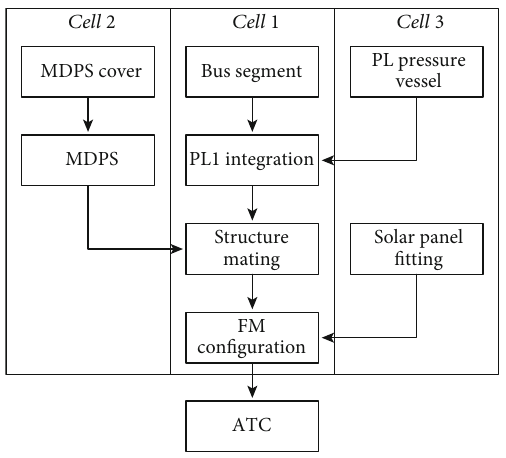
Figure 6: Integration fl ow of the Eu:CROPIS